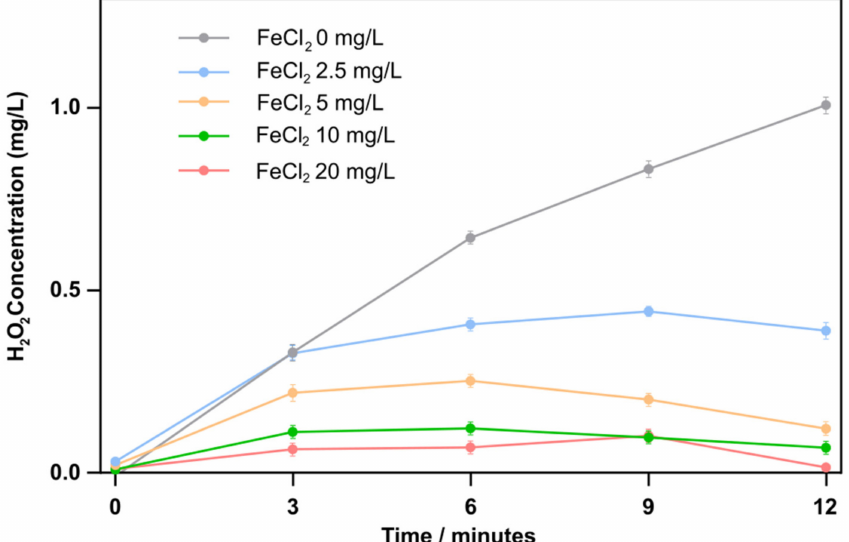
Figure 6. Time variation of H 2 O 2 concentration at pH = 4 with different amounts of FeCl 2